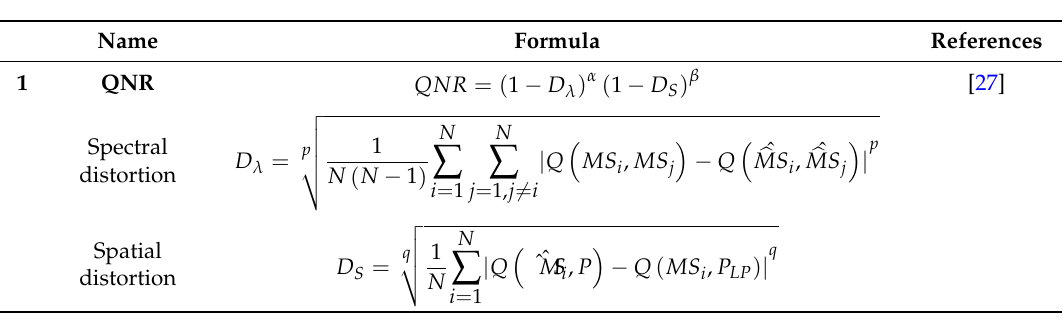
Table 4. Definition of the quality without reference index (QNR). Parameters p, q, α , and β were set to 1, as is recommended in